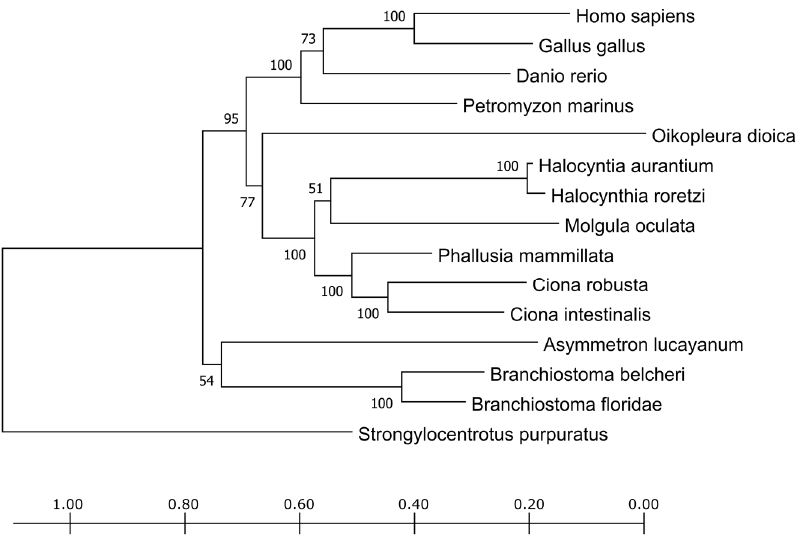
Figure 2. Phylogenetic tree of TPO proteins inferred by the maximum likelihood method. Pictured is the tree with the highest log likelihood ( − 20,923.40). The percentage of trees in which the associated taxa clustered together is shown next to the branches. Initial tree(s) for the heuristic search were obtained automatically by applying the neighbor-join and the BioNJ algorithms to a matrix of pairwise distances estimated using the JTT model as implemented in the software MEGA X [28] and then selecting the topology with best log likelihood value. At the bottom, there is the substitution per site, a standard measure for tree branch length. A total of 956 positions were considered in the alignment.